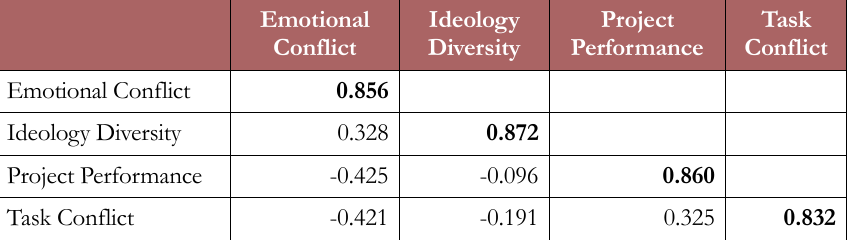
Table 7 . Discriminant Validity for Reflective Variables